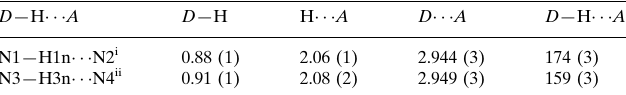
Hydrogen-bond geometry (A˚ , (cid:1)